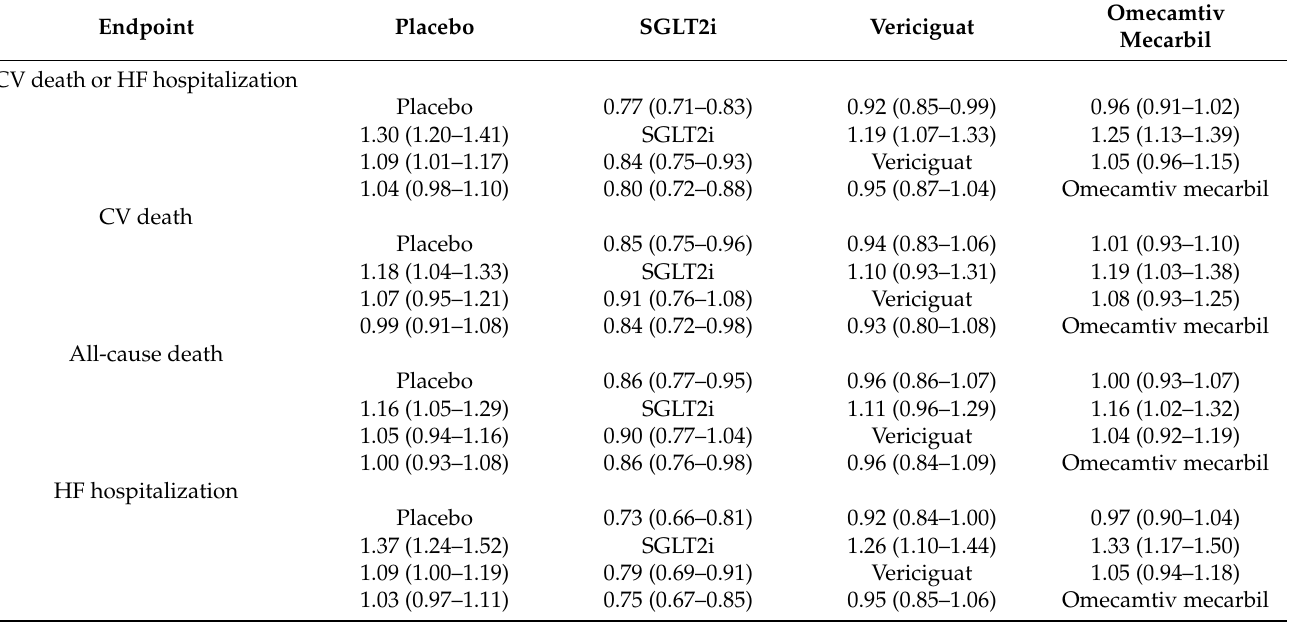
Table 2. League table showing pooled risk ratios for primary and secondary endpoints.